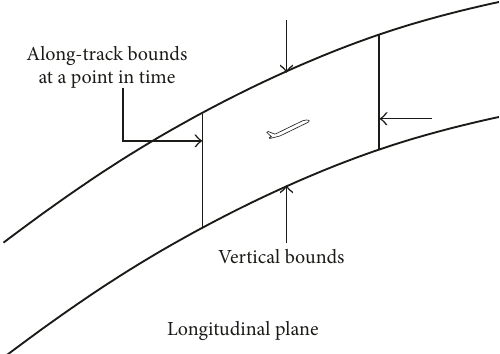
Figure 2: Trajectory bounds in the longitudinal plane